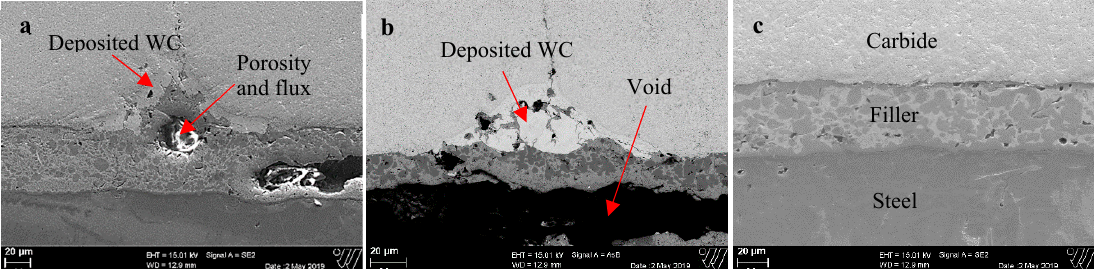
Figure 8. ( a ) Cross section of a groove ( b ) Groove with redeposited tungsten carbide and large void in the filler layer and ( c ) brazed region without grooves.